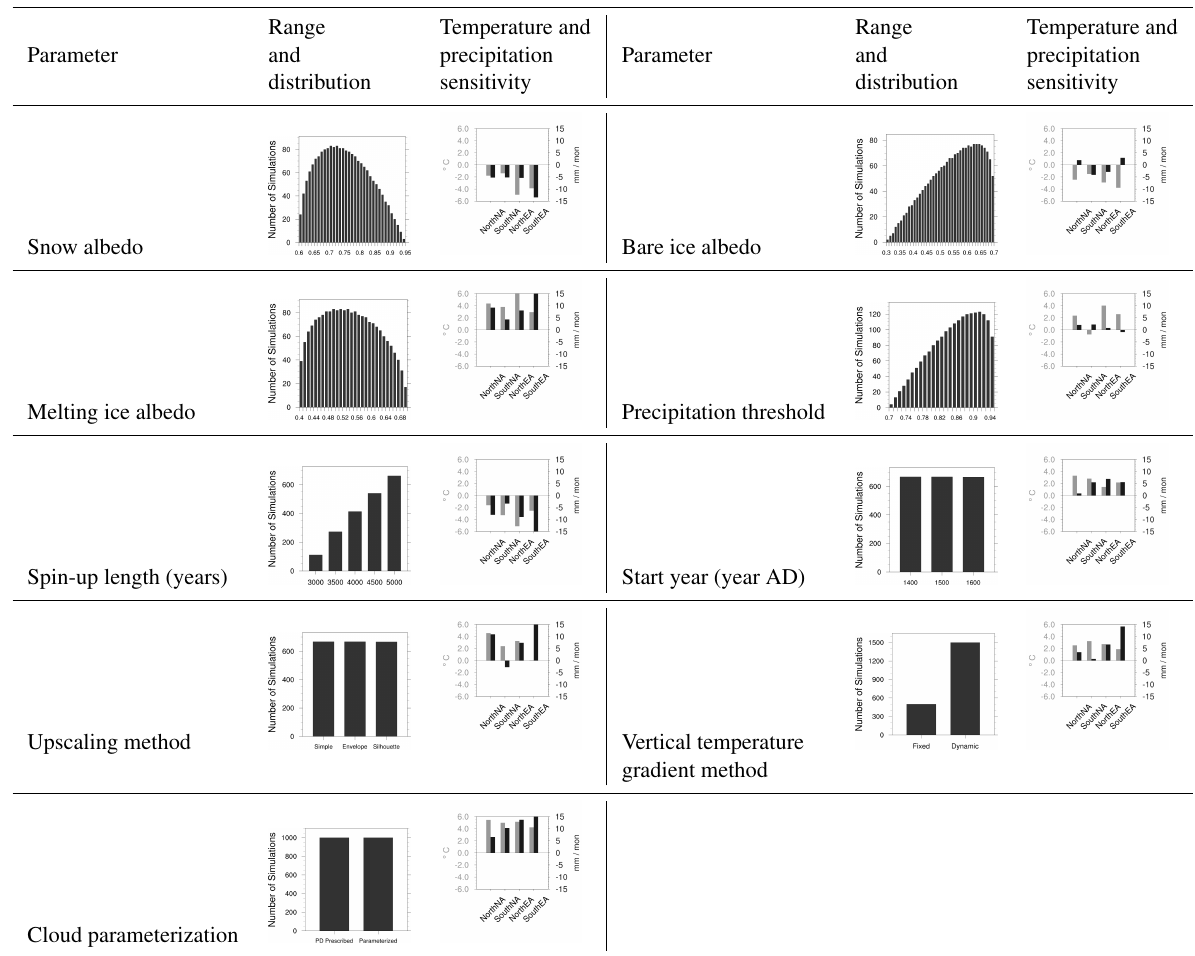
Table 2. Ensemble parameters that are varied in the historical transient simulation ensemble. Column 2: the distribution of parameter values versus their range for each parameter. Column 3: change in 1950–1980 CE mean summer 2m temperature and winter precipitation over four selected regions when each parameter is varied independently from its minimum to its maximum value. In each sensitivity run, all the other parameters are fixed to LOVECLIM default values, with a spin-up length of 4000 years, simple upscaling method, default LOVECLIM cloud radiative forcing, a start year of 1500CE, and a dynamic vertical temperature lapse